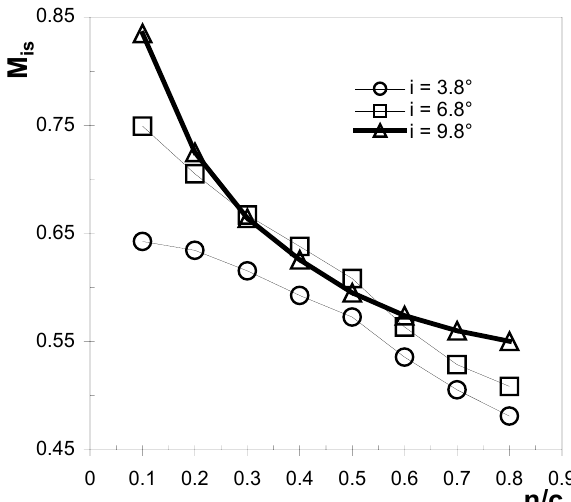
Fig. 7. Isentropic Mach number distribution on the controlled suction side - uncontrolled cases